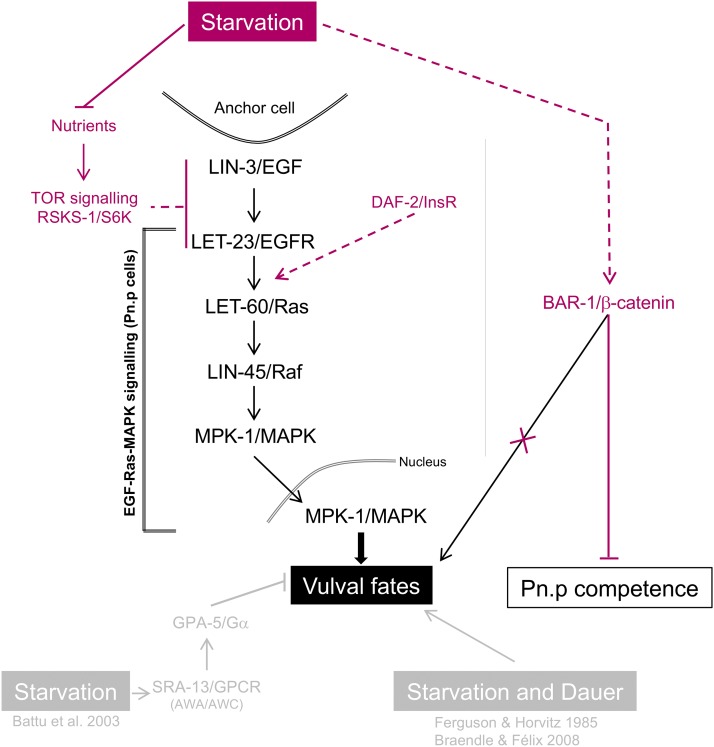
Starvation modulation of C. elegans vulval induction. Schematic representation of (antagonistic) starvation effects reported in this and earlier studies (Battu et al. 2003; Braendle and Félix 2008; Ferguson and Horvitz 1985).